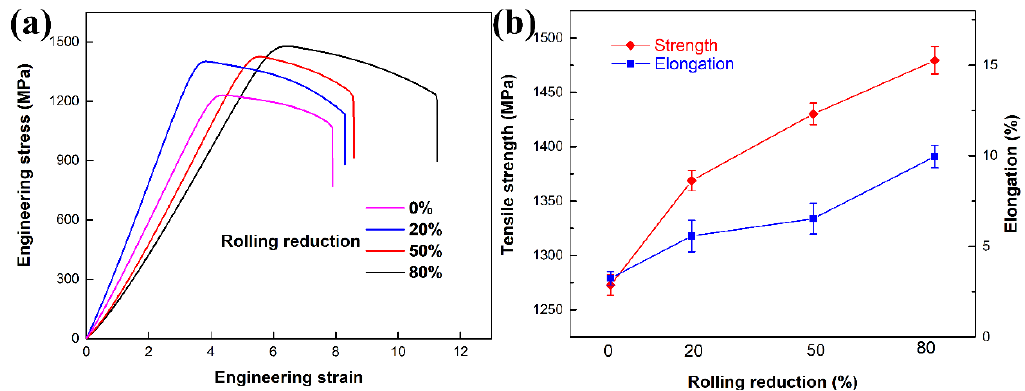
Figure 8. ( a ) Engineering strain-stress curves the aged samples. ( b ) Variations of average the ultimate tensile strength and elongation with rolling